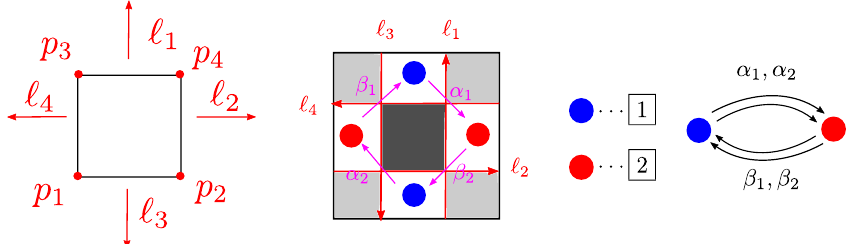
Figure 7. The toric diagram, periodic quiver (brane tiling) and quiver diagram for the conifold geometry. The lattice points of the toric diagram are denoted as p and p = (1 , 1) . External legs are denoted as ‘ 4 denoted α 1 , α 2 , β 1 , β 2